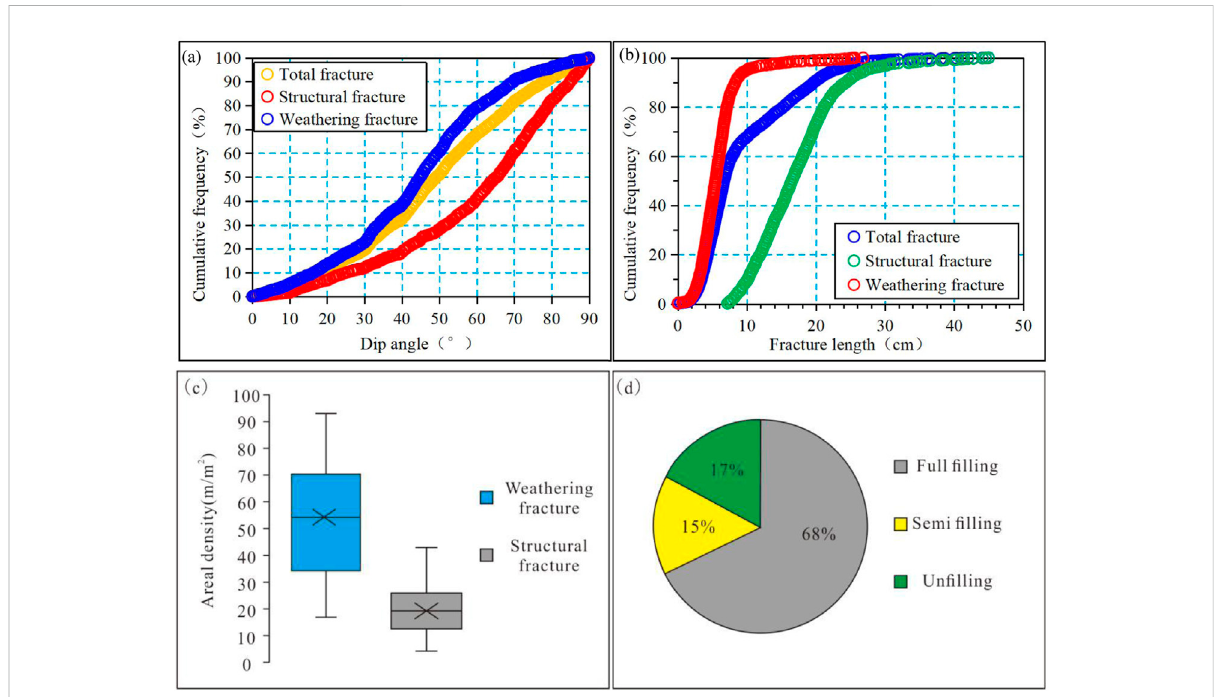
FIGURE 5 Quantitativecharacterizationoffractureparametersandfracturedistributiononcores. (A) Dipangleoffracture. (B) Fracturelength. (C) Fracture intensity. (D) Fracture effectiveness.